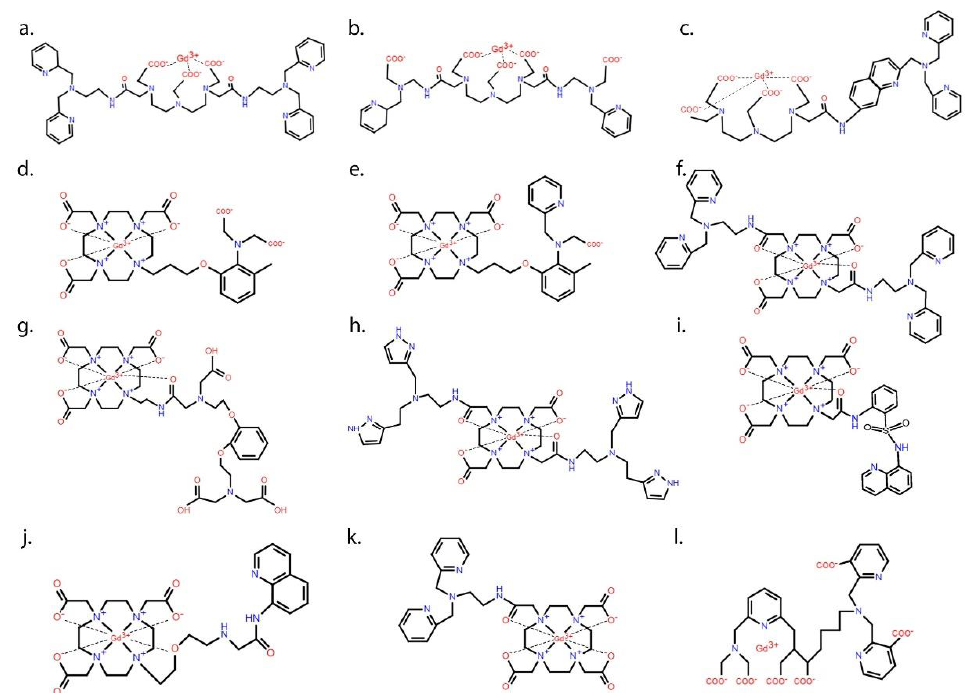
Figure 2. Chemical structures of some of the zinc-responsive gadolinium-based MR contrast agents. Acommonstructuralmotifof mostagentsisahigh-a ffi nitychelatinggroupsuchasDTPA (structures a – c )